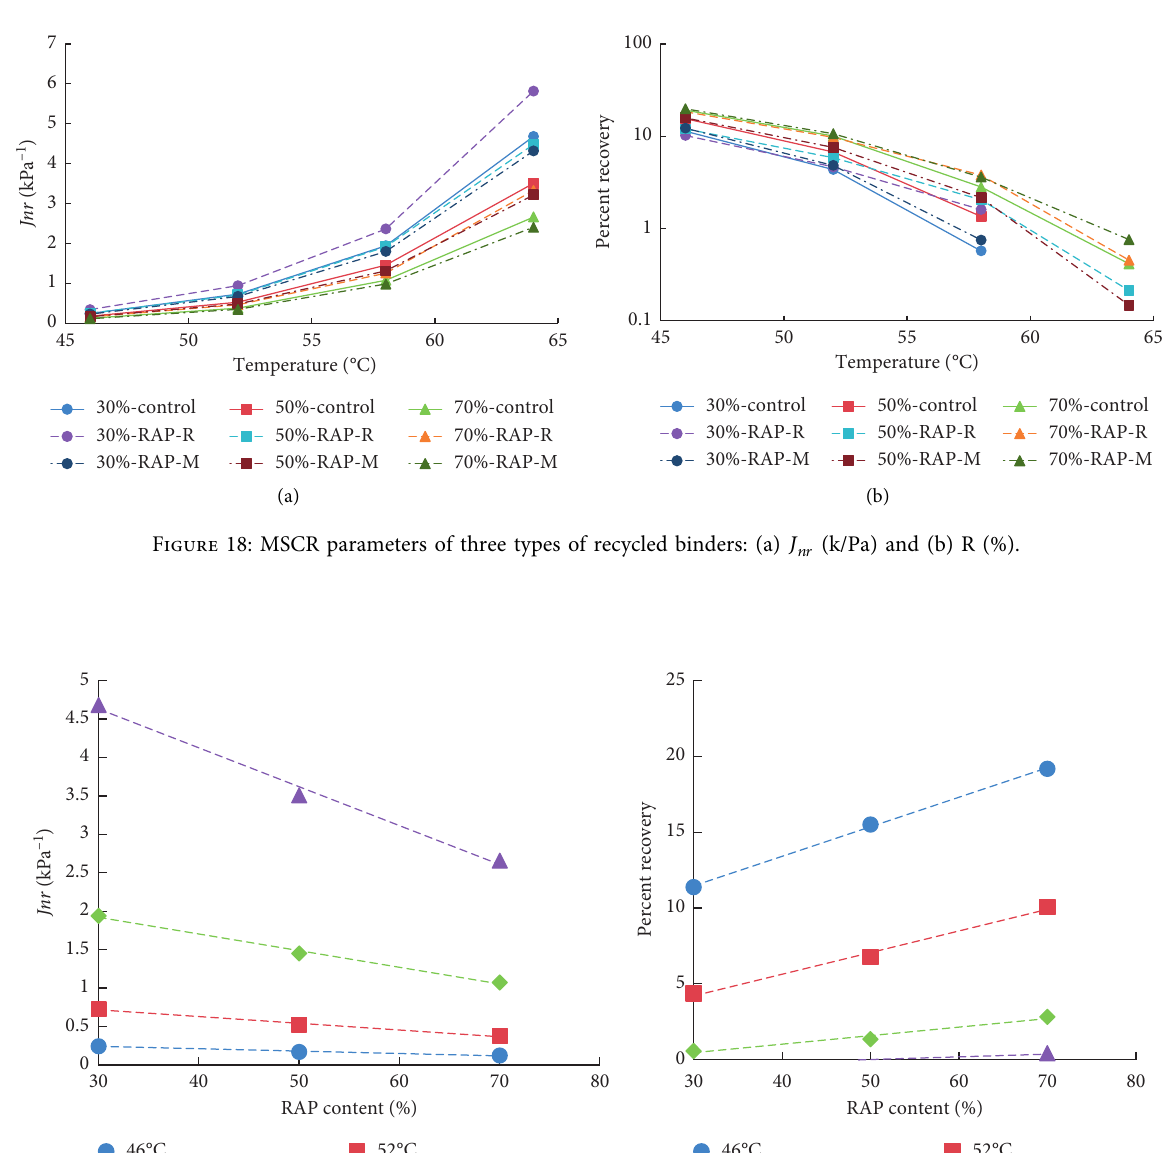
Figure 19: Relationship of aging asphalt content and MSCR parameters for control binders: (a) unrecoverable creep compliance and (b) creep percent